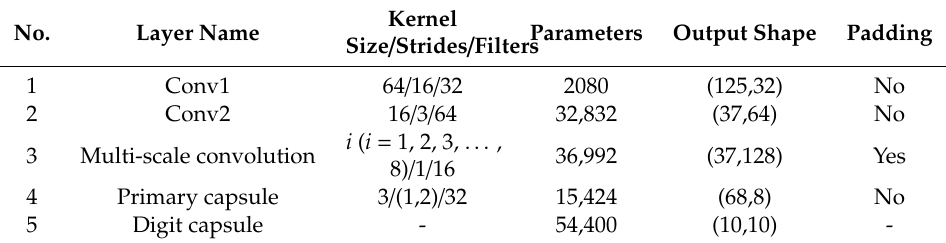
Table 1. Model structure